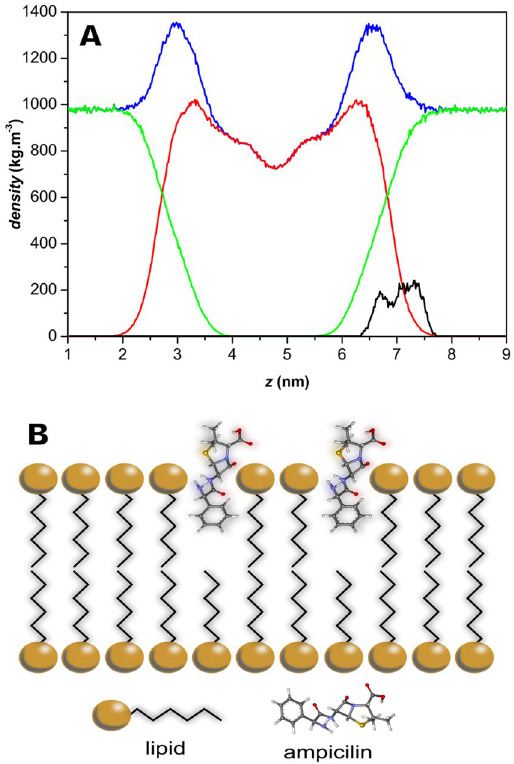
Figure 2. ( A ) Mass density profile (dp) of the simulated system (blue) between 190 and 200 ns and the contributions from the POPC molecules (red), the water phase (green) and the ampicillin molecules (black; multiplied by 10 to enhance visualization). ( B ) Schematic representation of ampicillin molecule and bacterial membrane interaction. This scheme is merely illustrative and is not in proportion to the actual size of the